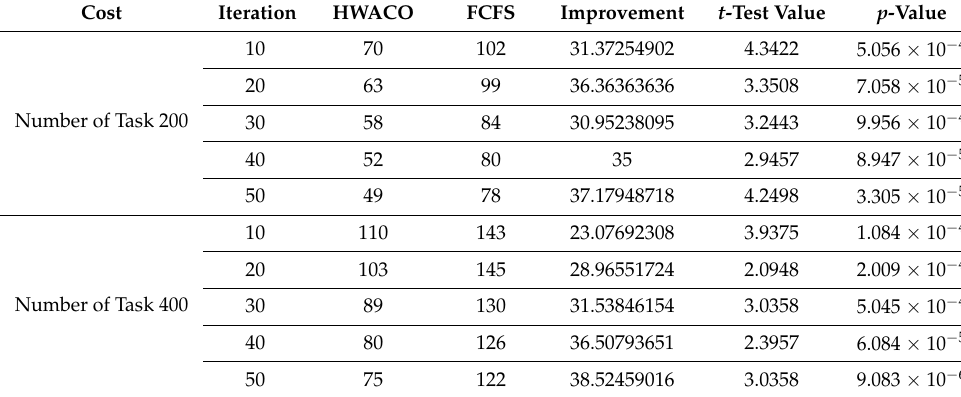
Table 13. t -Test for cost between HWACO and